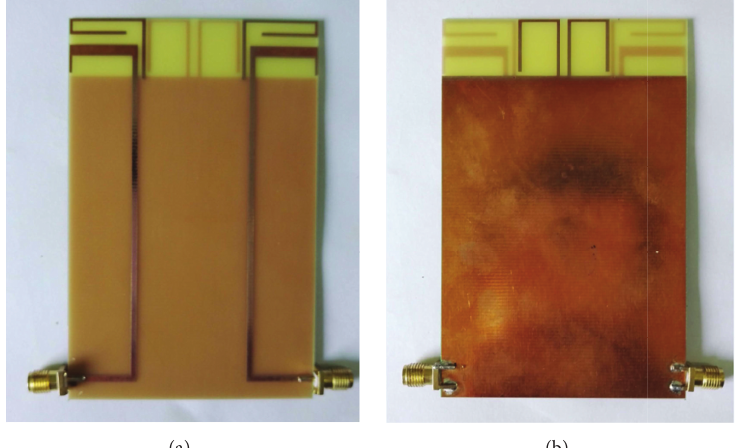
Figure 5: Photo of the fabricated antenna: (a) front view; (b) back view.